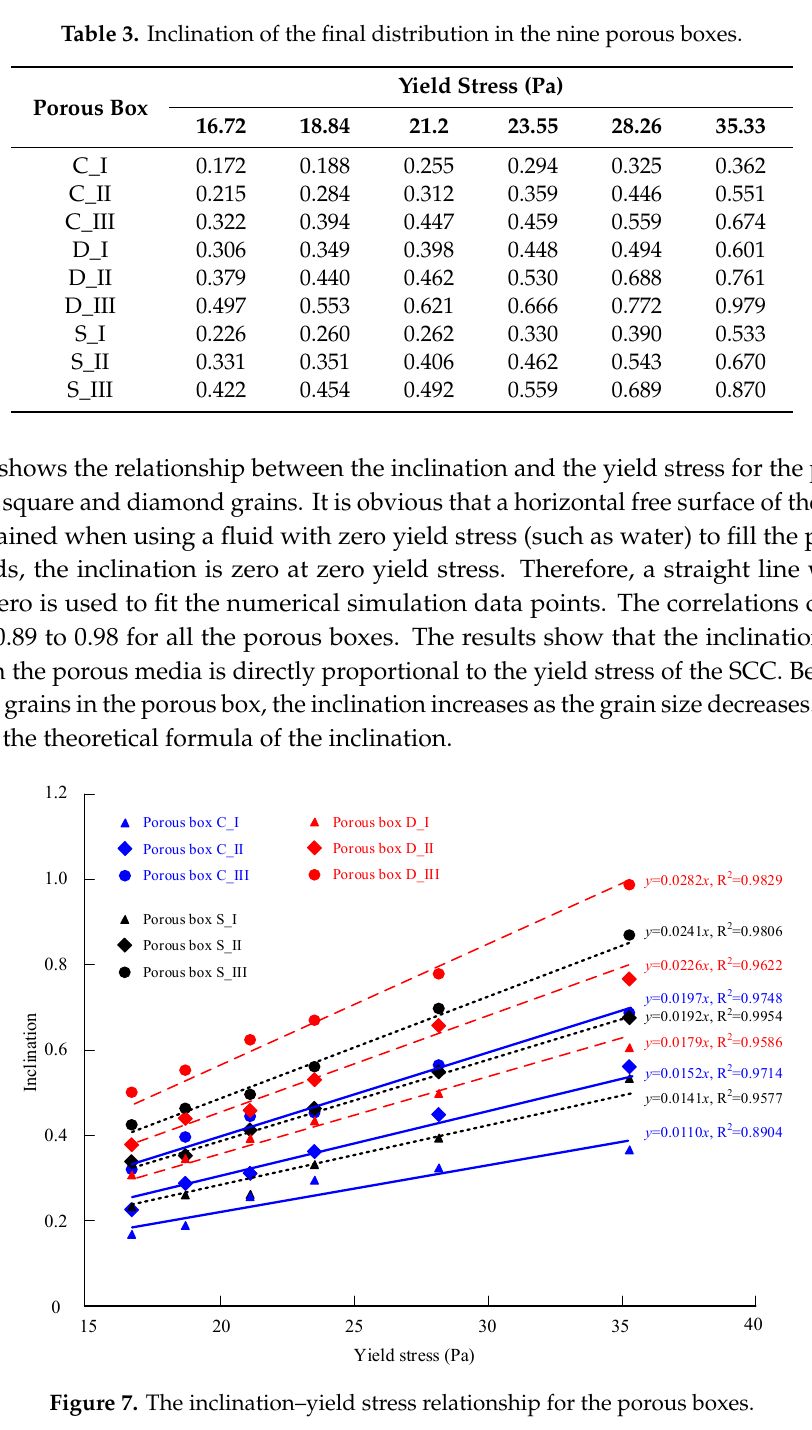
Table 3. Inclination of the final distribution in the nine porous boxes.